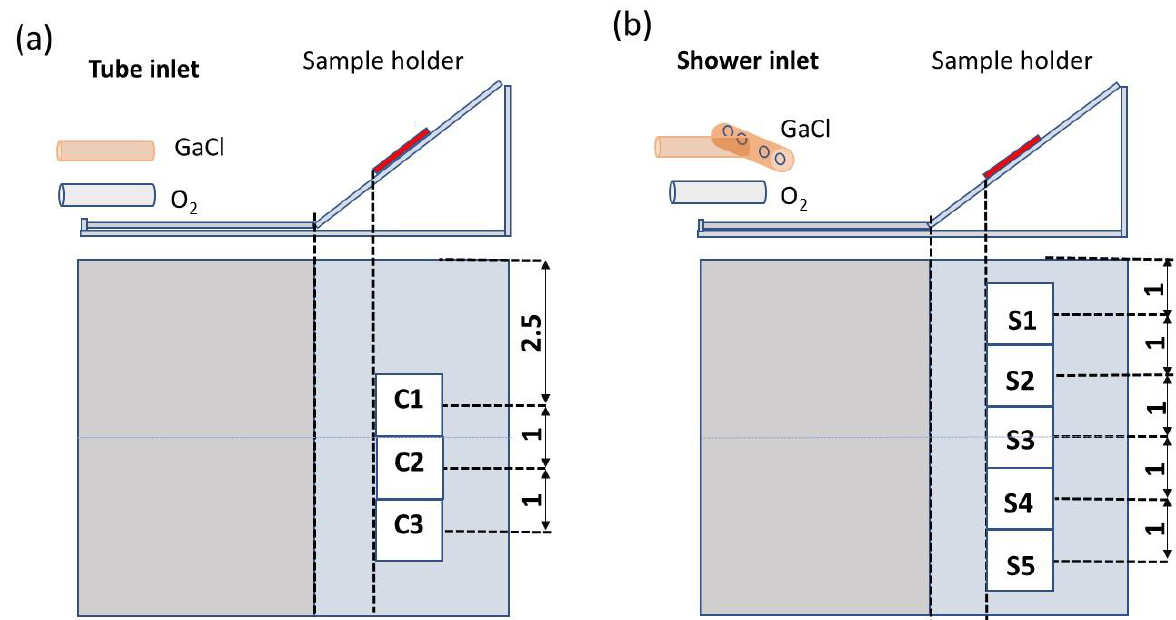
side-view of the substrate holder. The bottom drawing shows the positions of the samples with distances from the edge of the sample holder indicated in centimeters for each specimen. The samples are labelled C1–C3. ( b ) Similar schematic drawings as in ( a ), but for the shower head. Samples are labelled S1–S5.